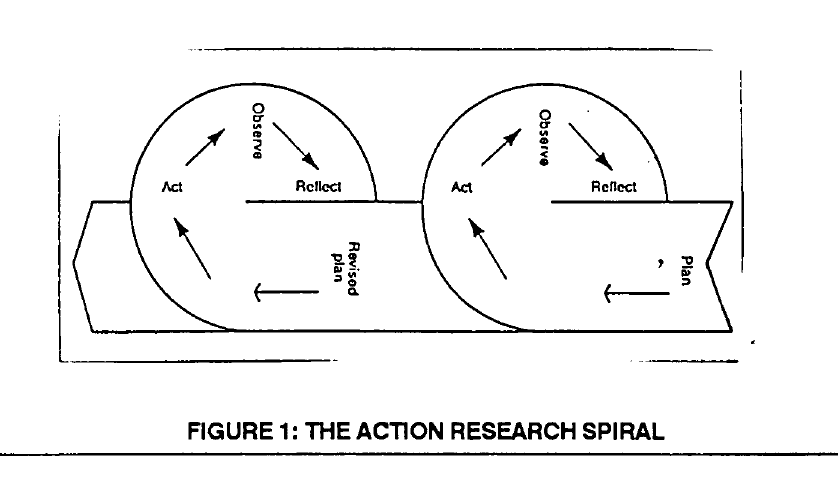
FIGURE 1: THE ACTION RESEARCH